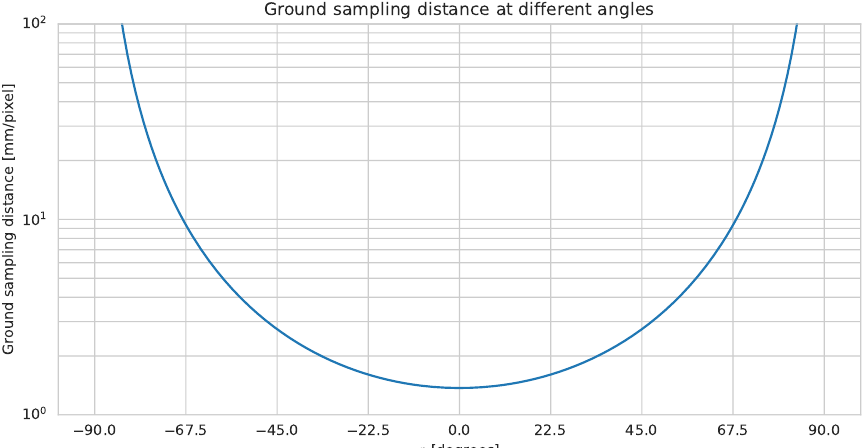
Figure 2. Ground sampling distance relative to camera angle, ϕ . ϕ = 0°corresponds to perpendicular to the driving direction. The calculations are based on a stationary camera. The effect of moving the camera is shown in Figure